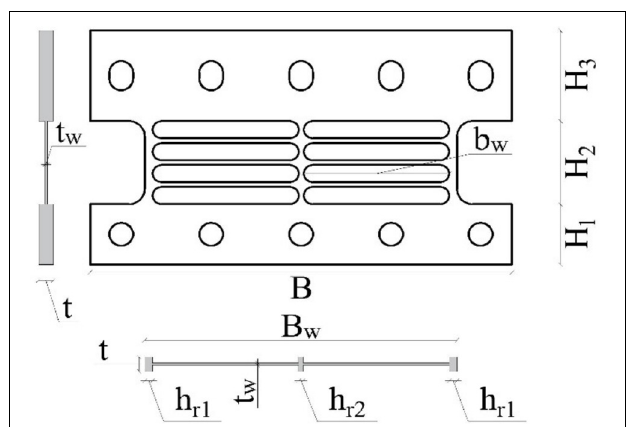
FIGURE 5 | Shear Link